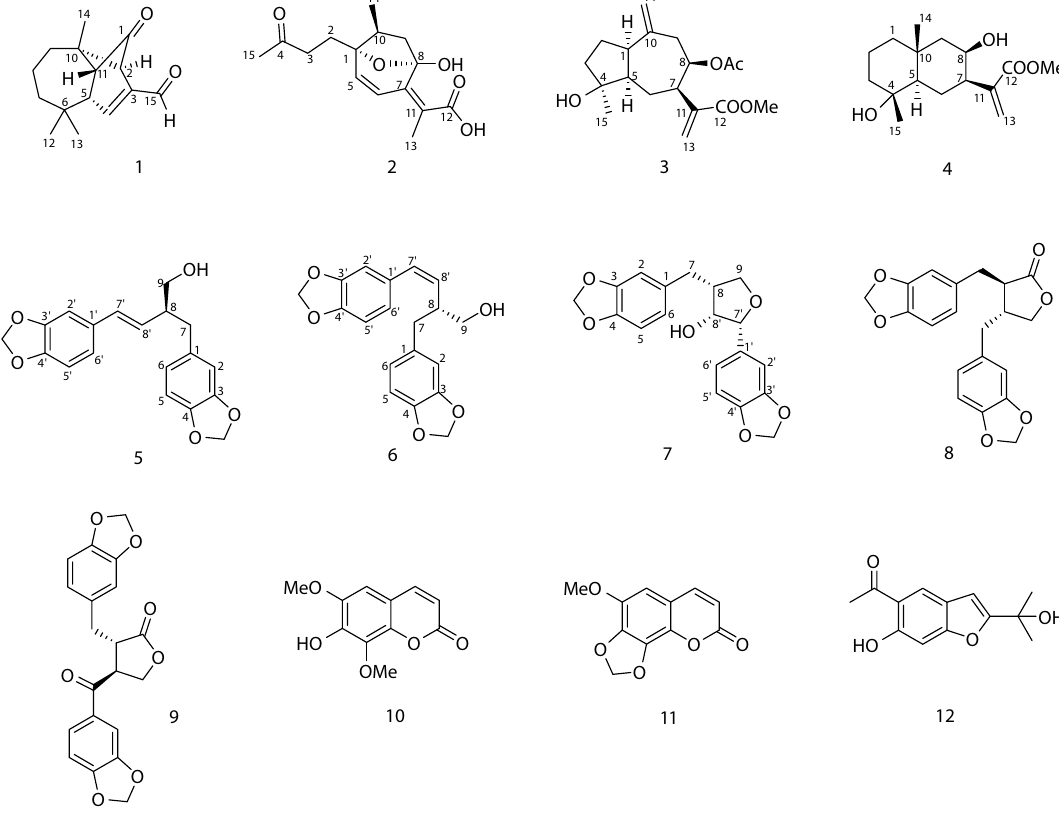
Fig. 1 Chemical structures of compounds 1 –